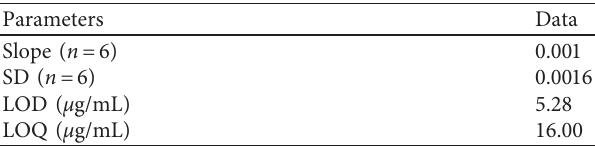
Table 3: Intraday analysis of SRP.